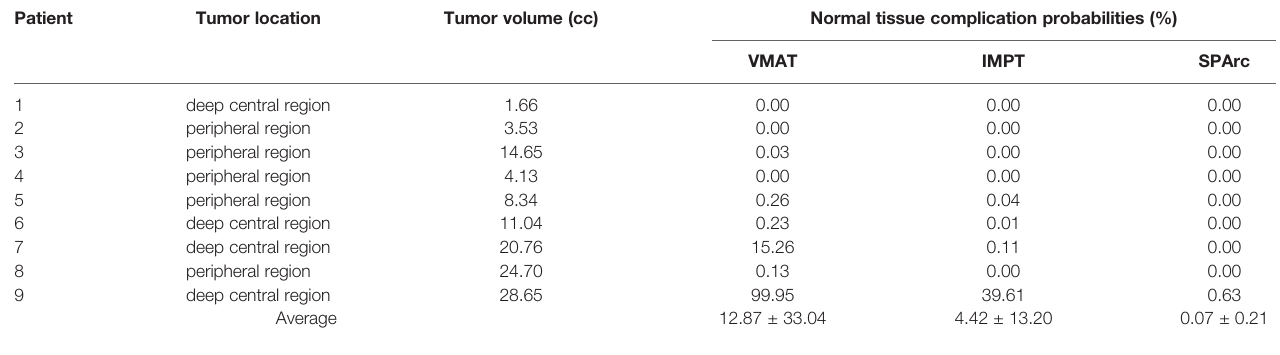
TABLE 4 | Normal tissue complication probabilities (%) calculated using a LKB model based on the Burman et al. Tolerance data. Patient Tumor